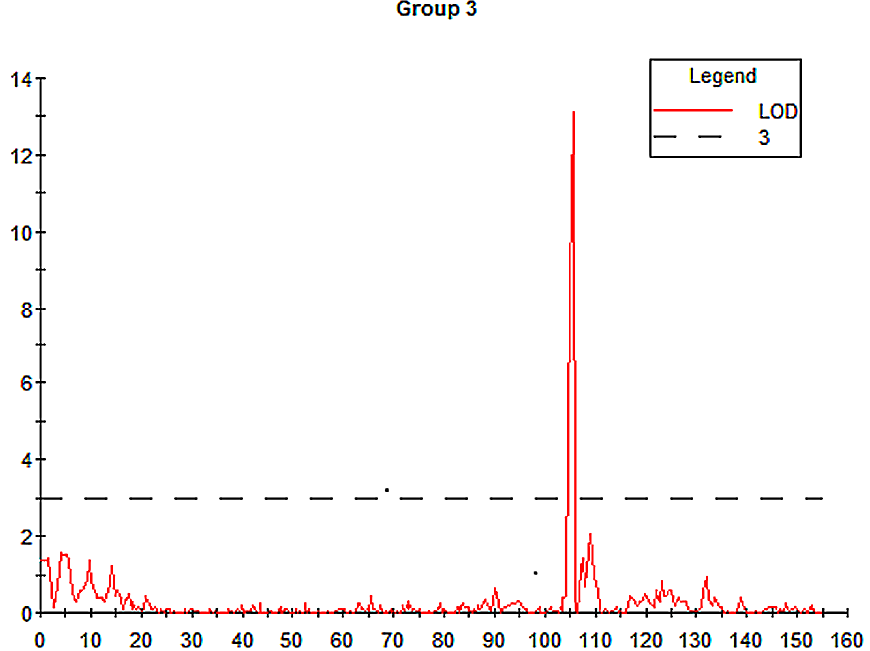
Fig 3. QTL mapping result for plant height in barley. Mapping QTL for plant height was conducted in the DH population of AC Metcalfe and Baudin in MapQTL5.0. In the chart, the red curve indicated LOD value at any genetic position. The black dash line indicated that the LOD value was